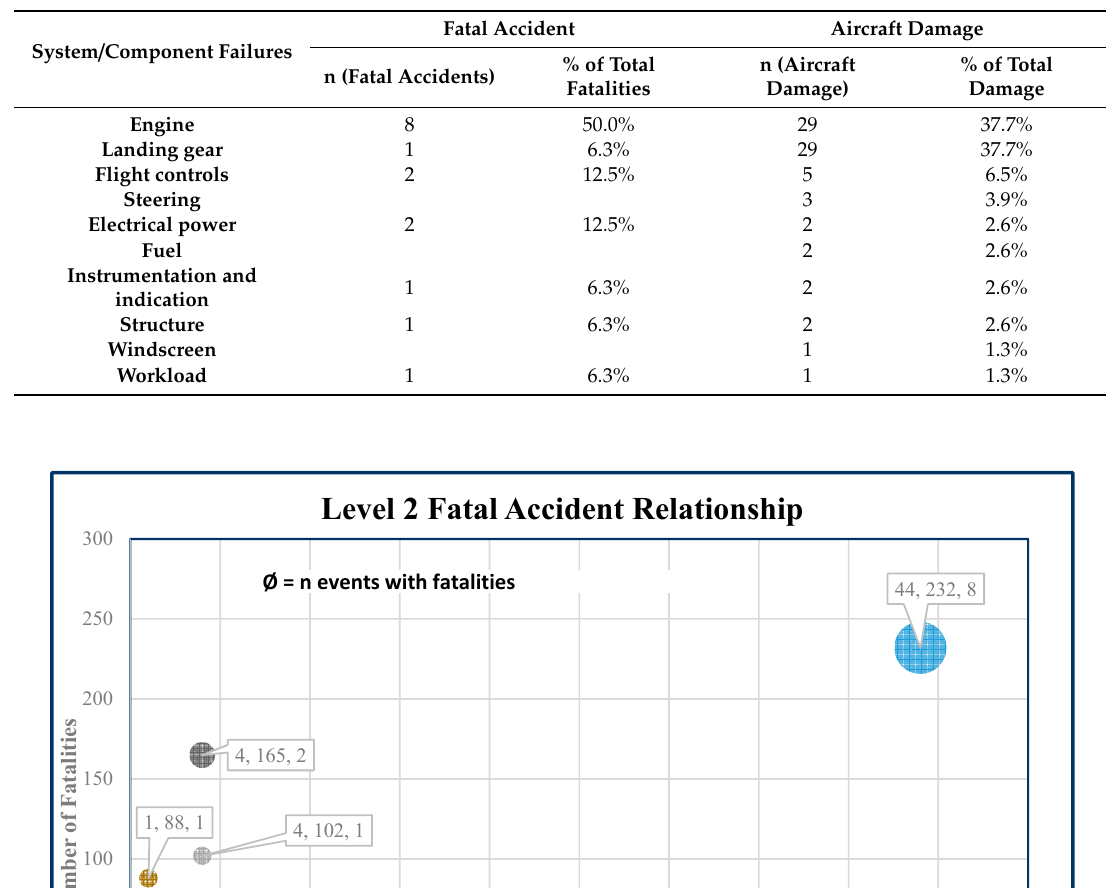
Table 8. Level 2 fatal accident and aircraft damage relationships.